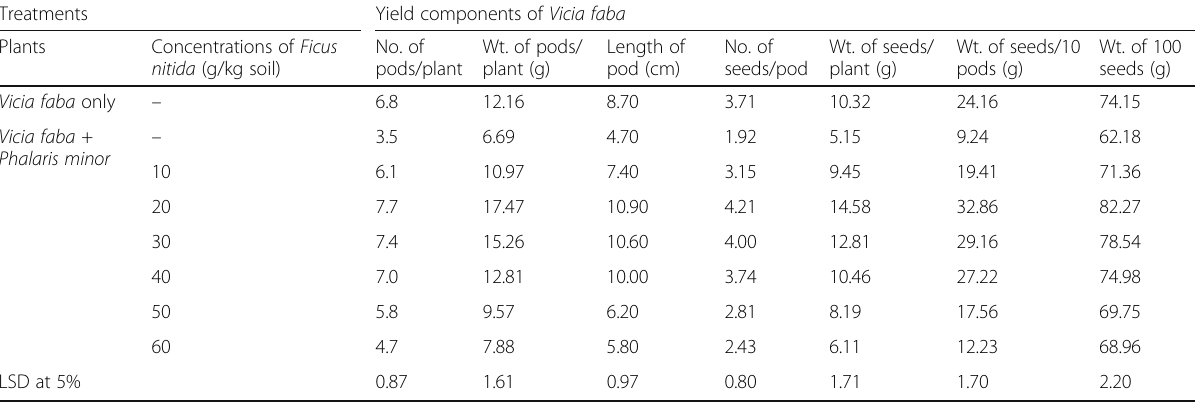
effect of the methanolic leaf and bark extracts of F . reduction recorded with the highest F . nitida leaf powder concentration (60 g/kg soil) reached to 69.8 and 80.3% respectively in the dry weight of P . minor and M . parviflora at 60 DAS as compared to their mixed control (Tables 1 and 2). These results are in increase the concentration used and this may be due agreement with the results reported by Manikandan to the presence of methanolic soluble allelochemicals and Jayakumar (2011); they showed the inhibitory Table 5 Effect of Ficus nitida leaf powder on yield components of Vicia faba plants associated with Phalaris minor at harvest (average of the two seasons) Treatments Yield components of Vicia faba Plants Concentrations of Ficus nitida (g/kg